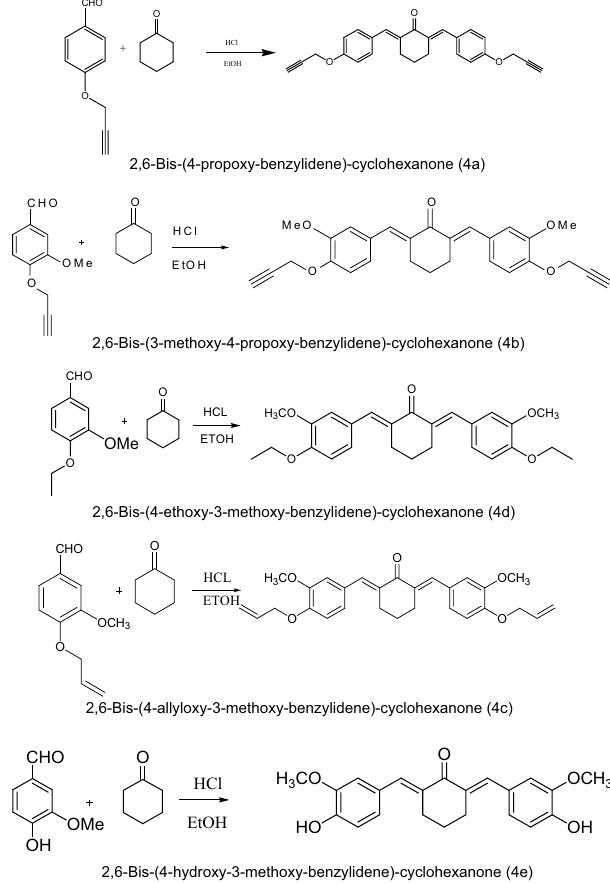
Figure 2. Synthesized 2,6-bis benzylidene cyclohexanones (4a – 4e also named BM1-